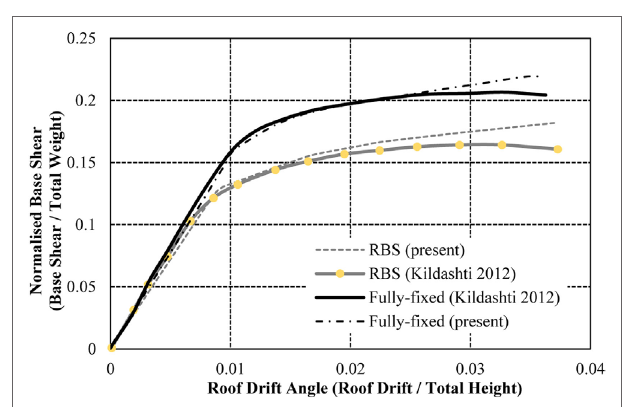
Figure 10 | NA vs EU sections normalized capacity curve comparison for 4-storey frame.